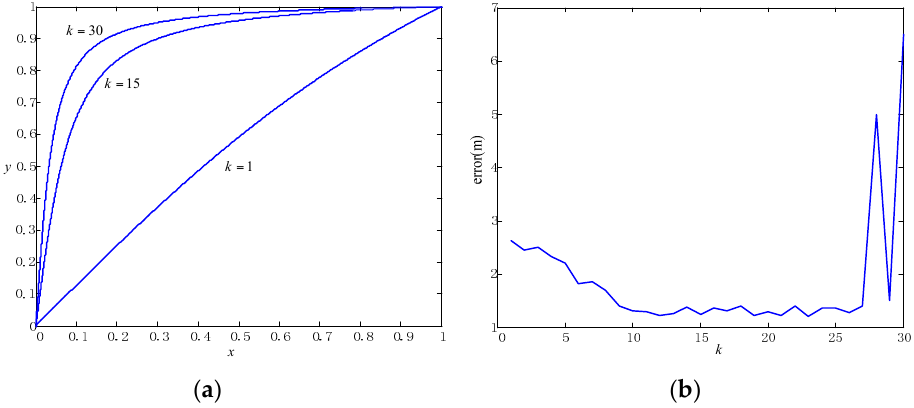
Figure 9. ( a ) The different values for the parameter k in the rewarding function correspond to different extents of convex; ( b ) the curve of positioning errors against different values of k .